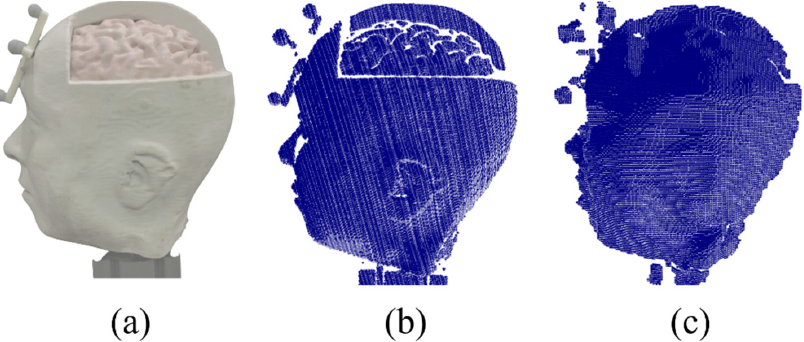
Figure 17. Comparison of the 3D reconstruction of a human plaster: ( a ) Original, ( b ) our system ( c ) and ( c ) SR305.